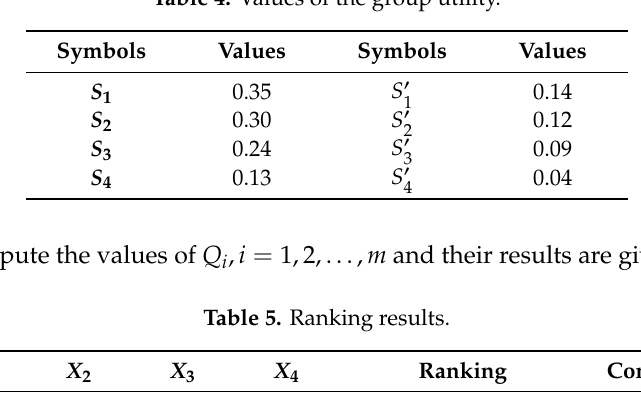
Table 4. Values of the group utility.